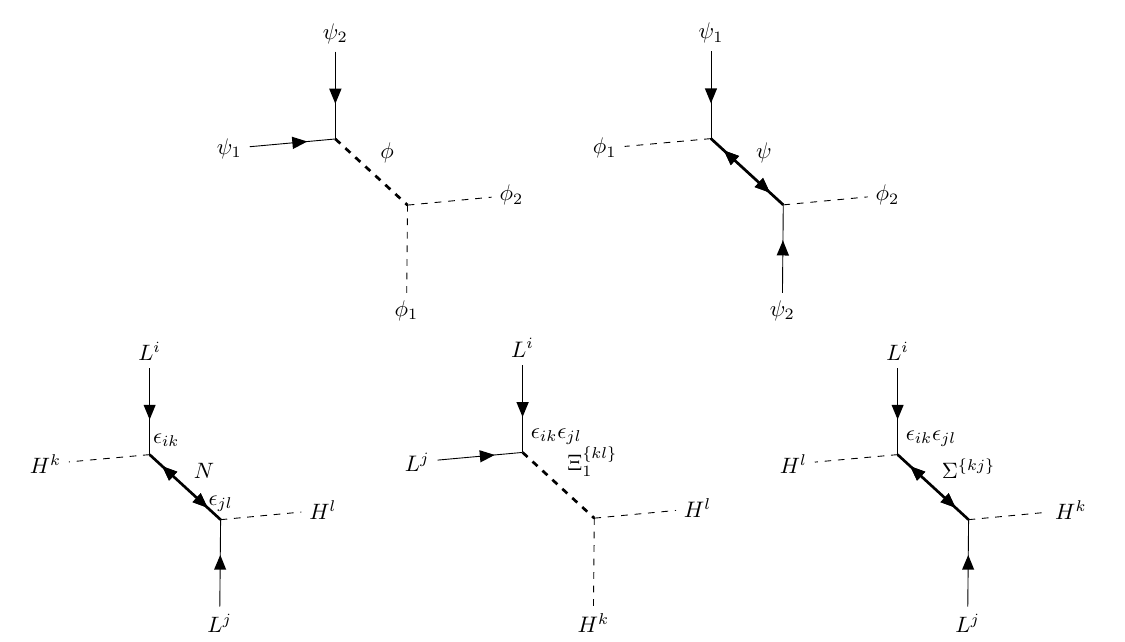
Figure 1. Above: scalar-only and fermion-only topologies which complete dimension-five two- scalar-two-fermion operators, like the Weinberg operator O 1 . Below: the three minimal tree-level completions of O 1 , each corresponding to a different permutation of the fields on the external lines of the topologies. These are traditionally called (read from left to right) the type-I, type-II and type- III seesaw models. The SU(2) L indices are included explicitly to distinguish type-I and type-III, while making a more clear connection to eq. (3.15). The exotic propagators are shown in